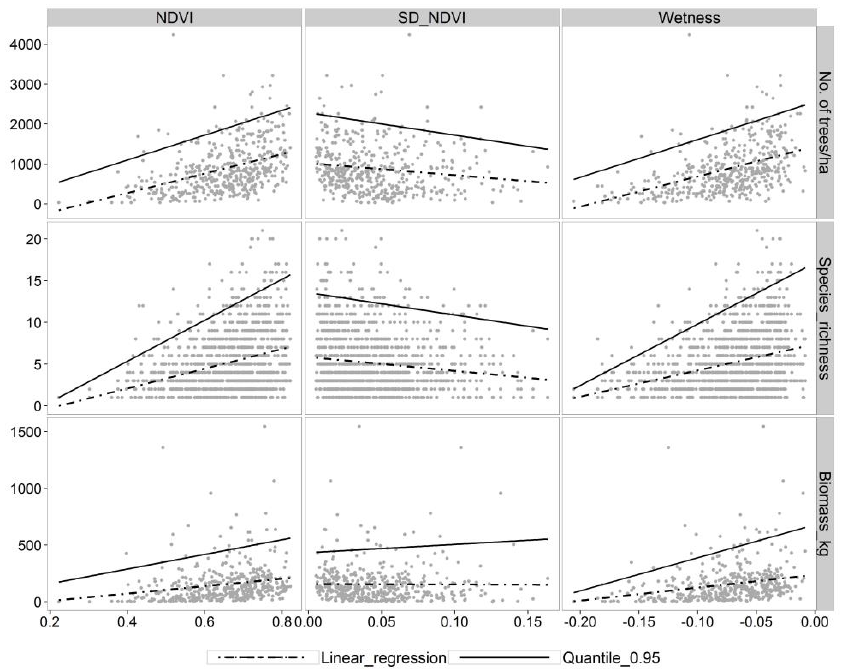
Figure 3. Relationship between tree density (no. of trees/ha), species richness and biomass (kg) with NDVI, SD–NDVI and wetness using quantile regression (0.95 tau) and linear regression. The dashed line is for linear regression and solid line is for quantile regression (0.95